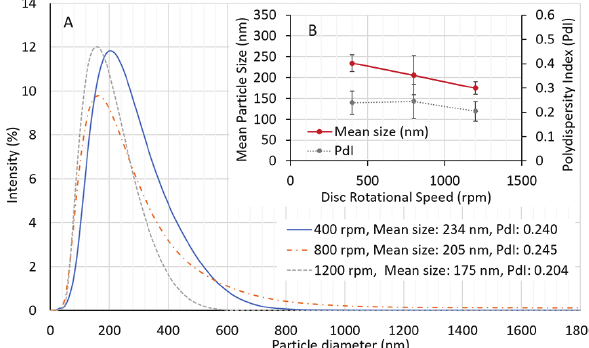
Figure 6: Effect of disc rotational speed at 9:1 antisolvent to solvent ratio and 18 mL/s flow rate on the grooved disc, (a) PSD, (b) plot of mean particle size and